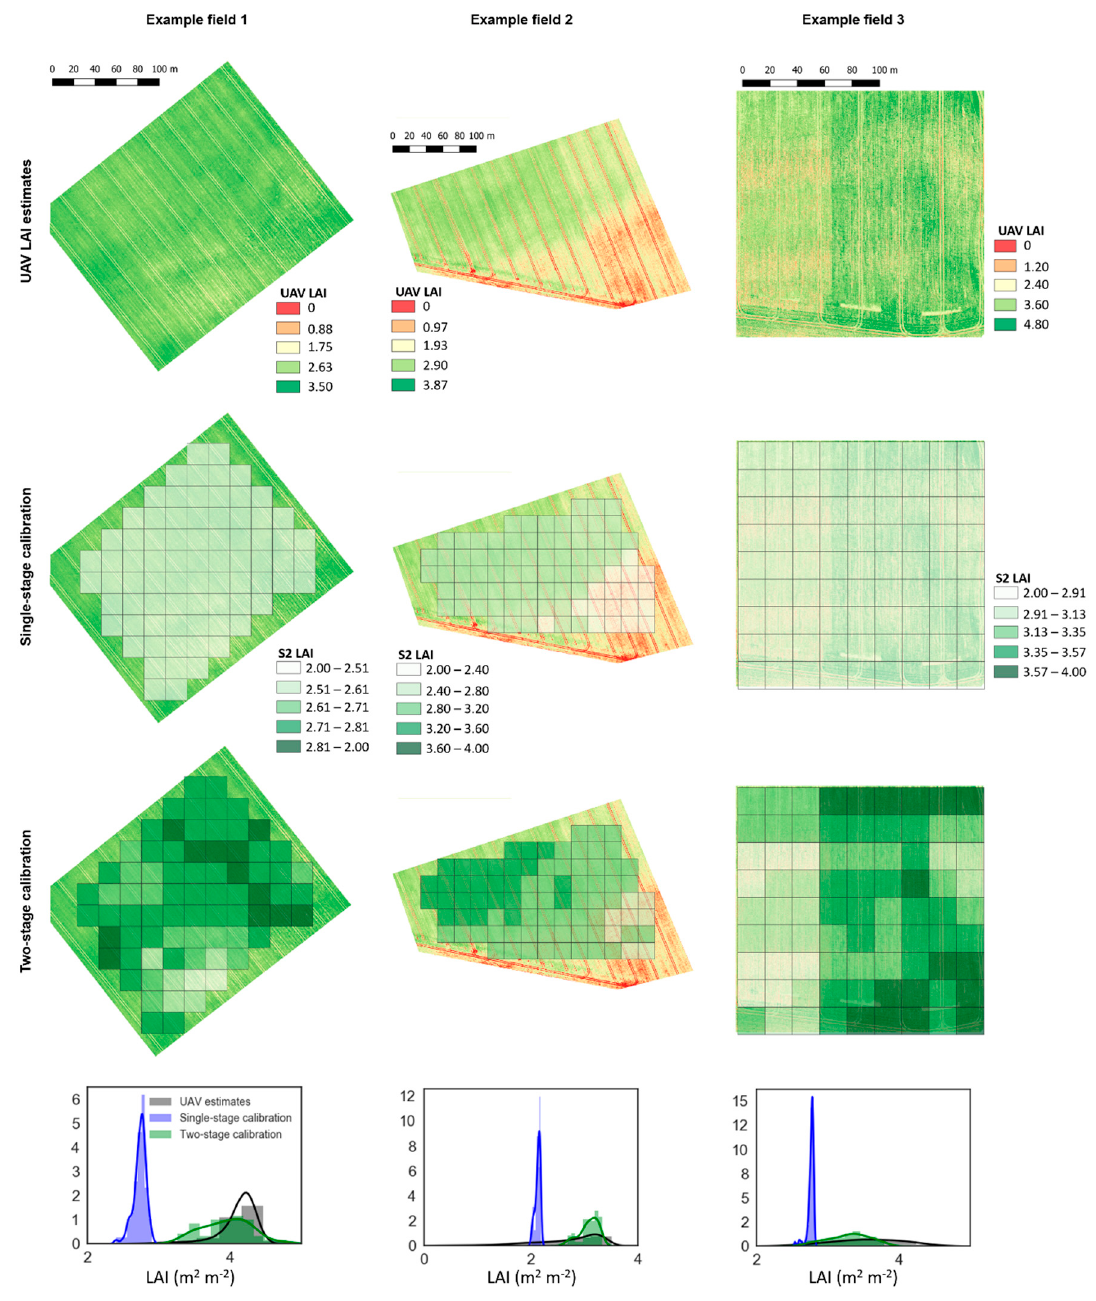
Figure 8. Example LAI maps and distributions of three fields. From the top row, fine-scale UAV LAI estimates (row 1), Sentinel-2 estimates derived from the single-stage GPR model calibration (row 2), estimates from the two-stage calibration (row 3) and plots comparing the distribution of LAI values amongst the UAV and GPR model estimates (row 4).